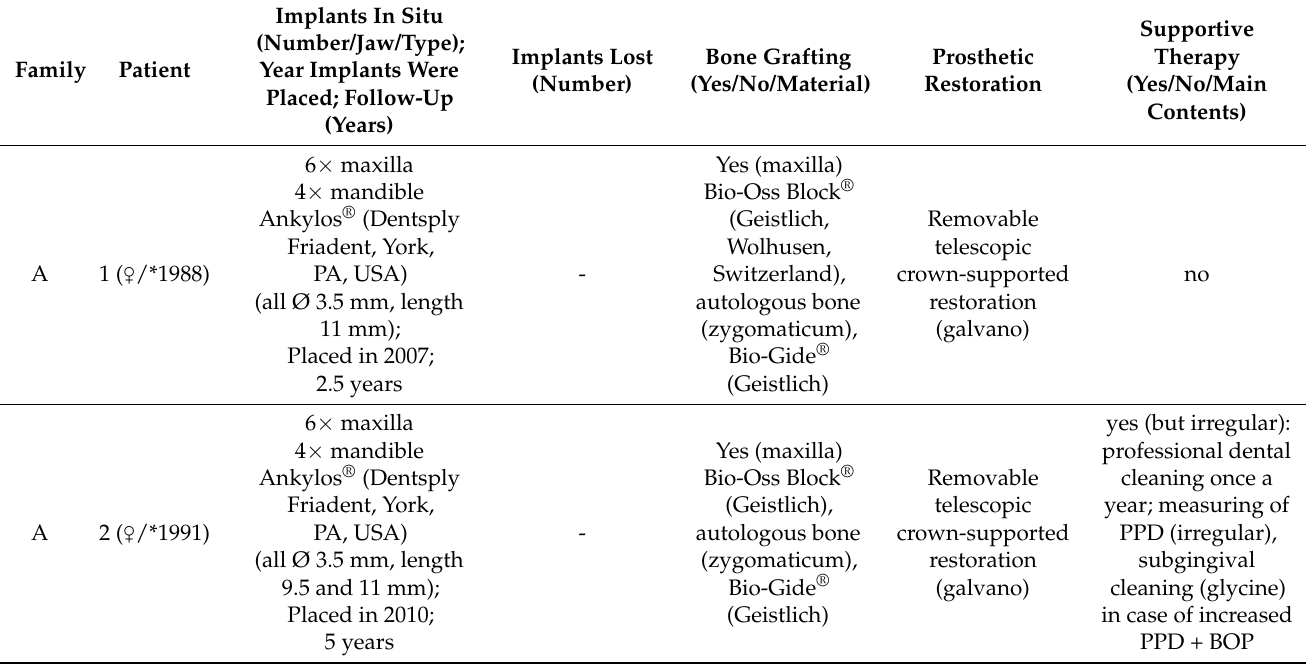
Table 1. The patients included and their dental implant